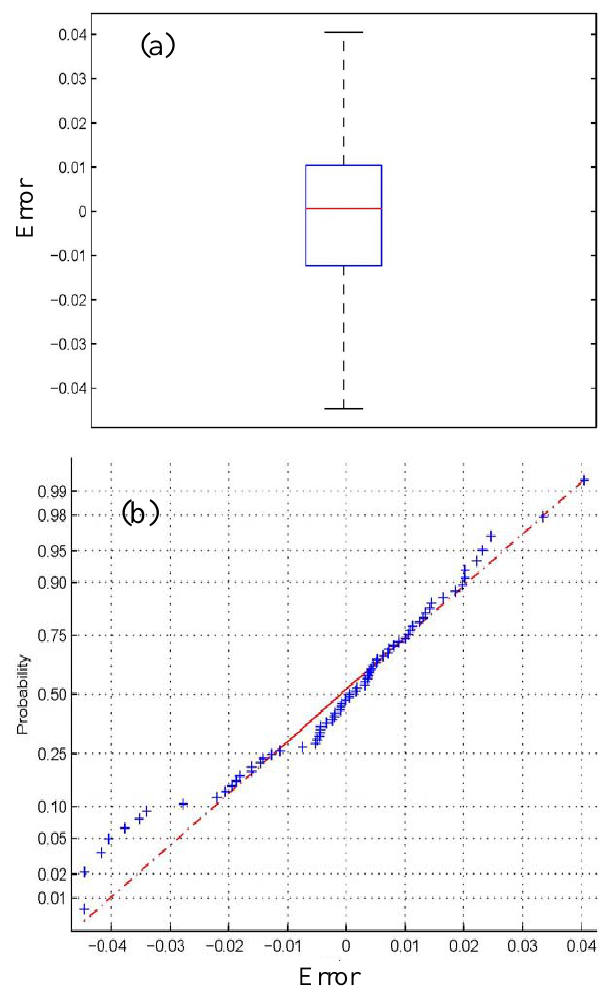
Fig. 4. (a) Statistics of error estimate for the data shown in Fig. 3. The median, 25th and 75th percentiles and the range are shown with outliers excluded. (b) Estimation error normality, a straight line in- dicates a normal